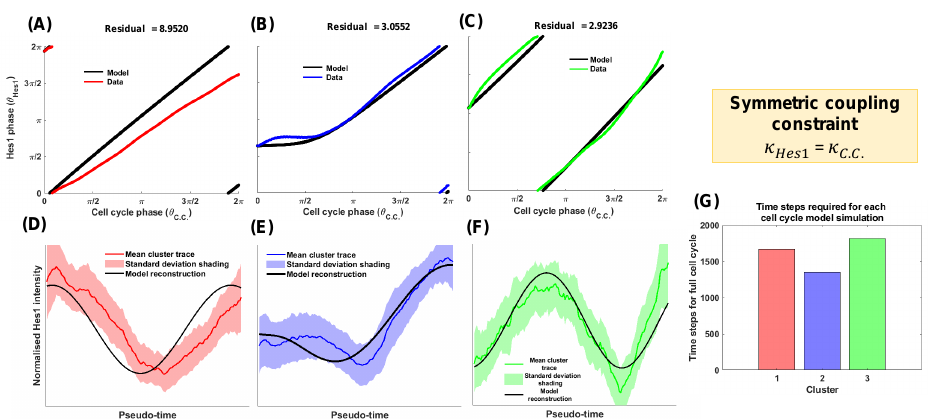
( i ) is Hes1 ( i ) , i = 1, 2, 3 superimposed Hes1